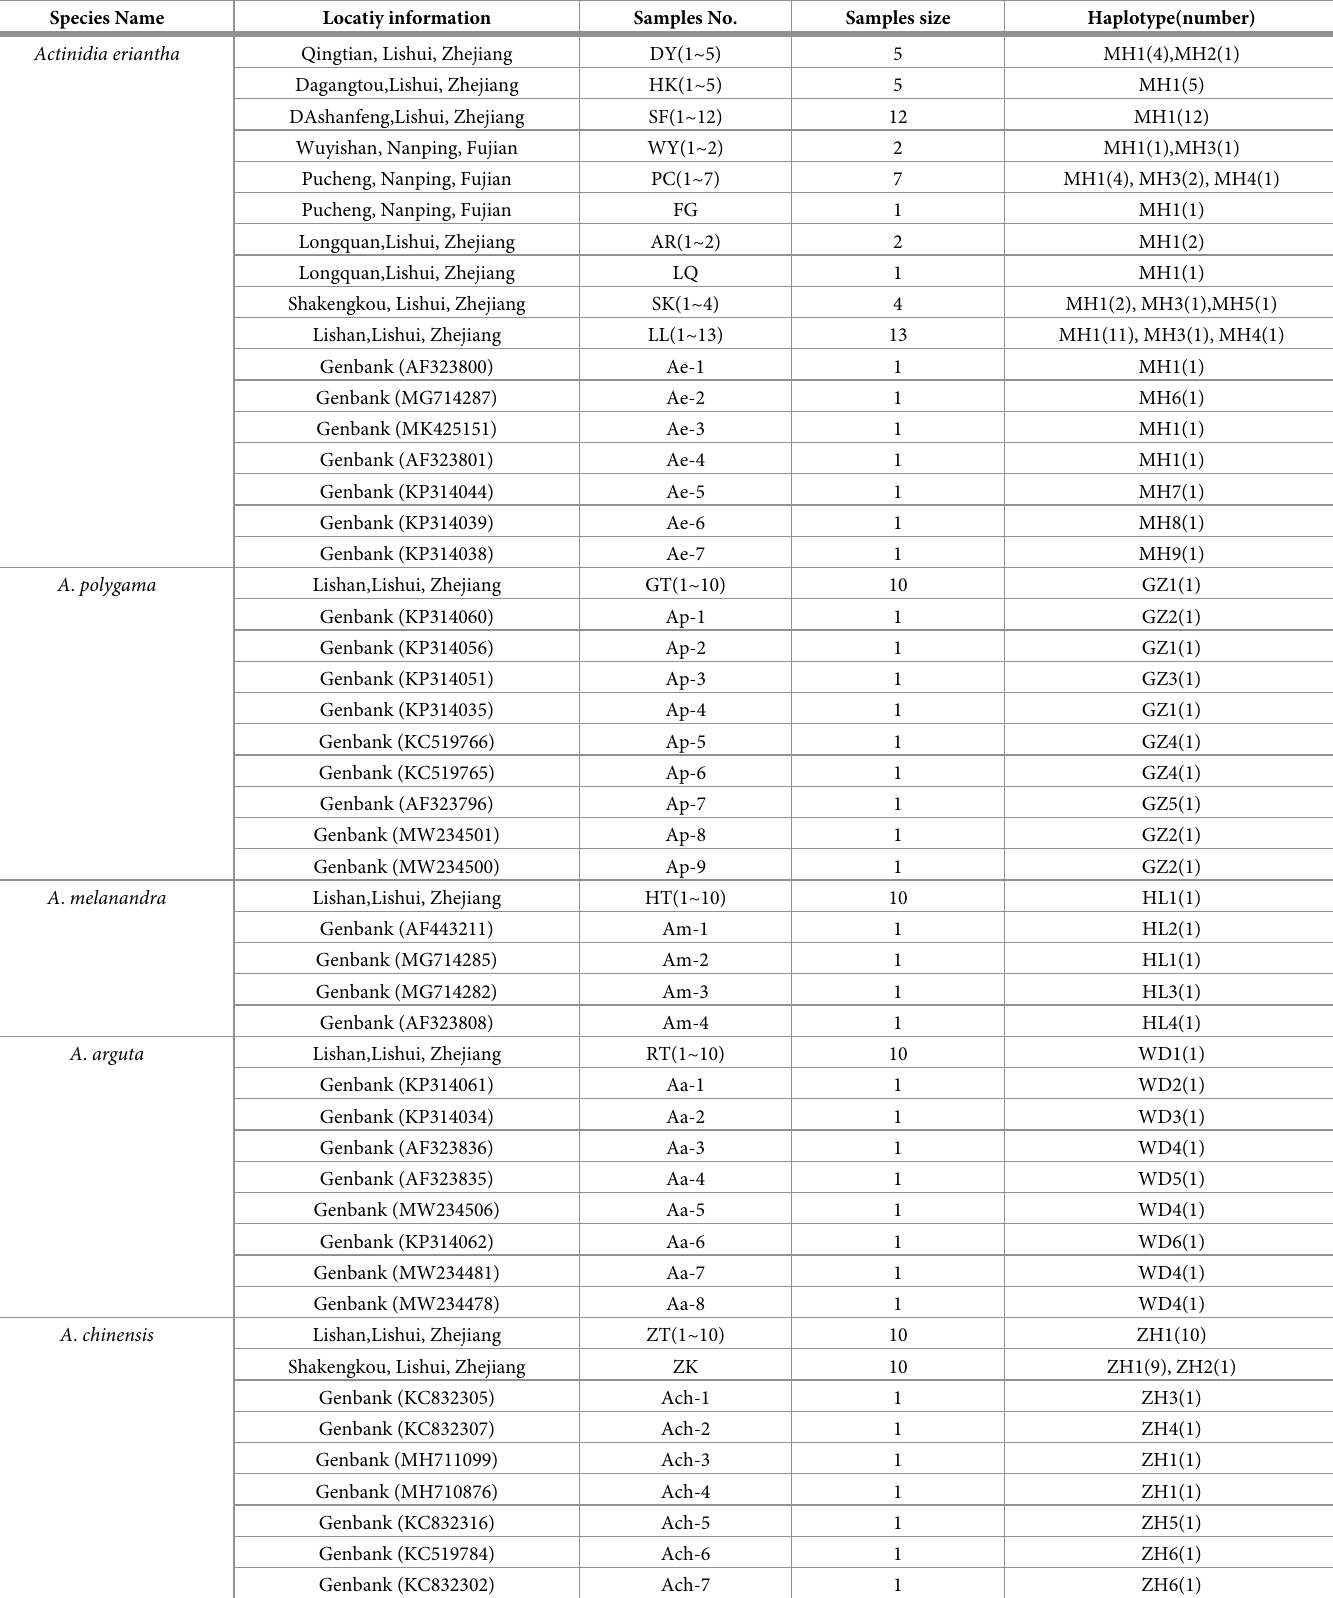
Table 1. Samples